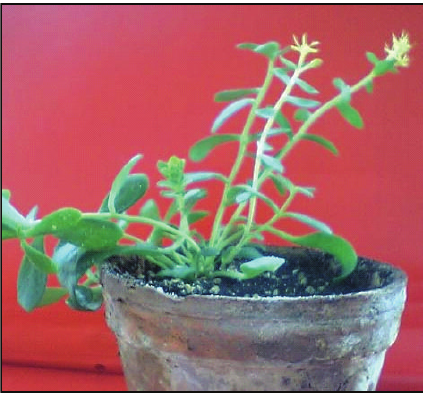
Figure 8: Adaptation of Rh. rosea regenerants in mixture of perlite, peat, and soil [69].